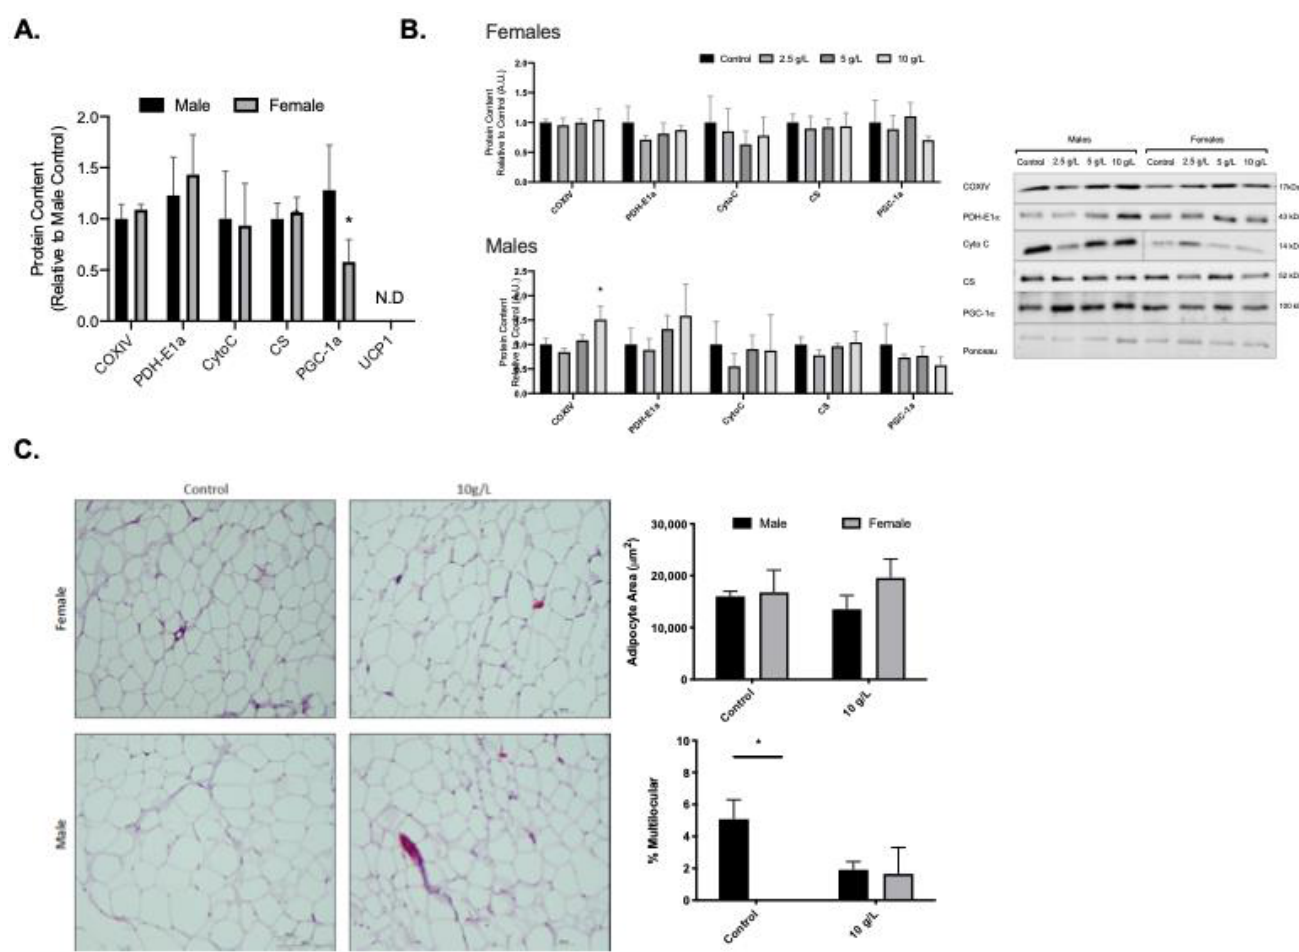
Figure 2. Visceral gonadal white adipose tissue (gWAT) mitochondrial protein content and morphology. ( A ) Quantified Western blot data for gWAT protein content of COXIV, PDH-E1α, Cytochrome C (Cyto C), citrate synthase (CS), PGC-1α, and uncoupling protein-1 (UCP1) for control male and female rats. ( B ) Quantified Western blot data for mitochondrial proteins across creatine supplemented groups and representative Western blot images. ( C ) Representative images of H&E stained slides. Scale bar on H&E representative image represents 100 μm. Data were analyzed by ANOVA and are presented as mean ± SEM, * denotes significantly different from control group, p < 0.05.